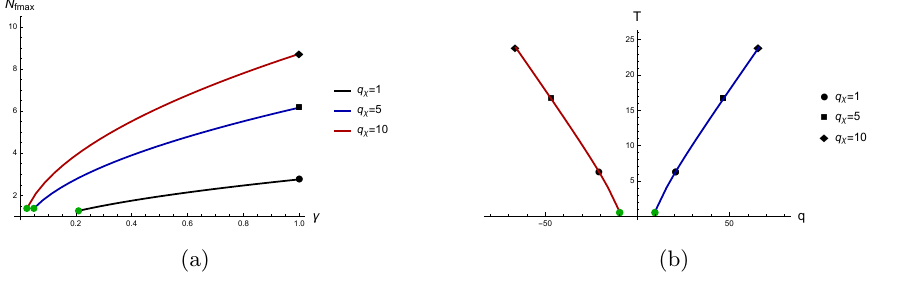
Figure 18 . (a) Maximum value Nernst signal for di(cid:11)erent (cid:13) and q (cid:31) . (b) Position of maximum and minimum of Nernst